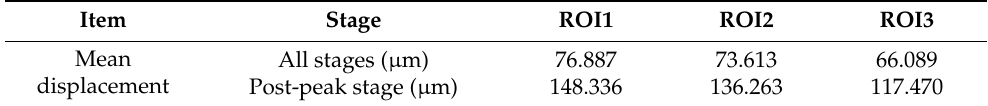
Figure 10. Statistical results for the ROI2 displacement field at different stages (stage 2 to 8). Table 1 lists the mean displacements for the post-peak stage and the full stress–strain process of ROI1-3. Table 1. Mean displacements of different